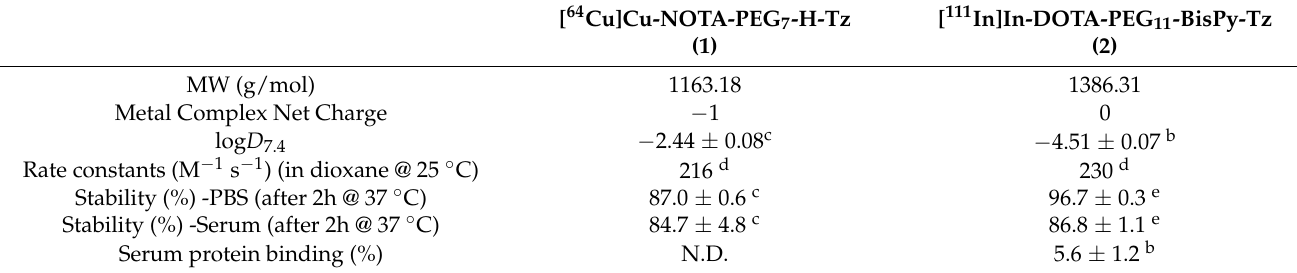
a Comparison of various physicochemical properties and in vitro stability where MW = molecular weight and log D coefficient at physiological pH (7.4). Second order rate constants are estimated from measurements of the Tz structural classes with trans -cyclooctence (TCO). Stability represents fraction of intact Tz. N.D = not determined; b data taken from reference [23], c data